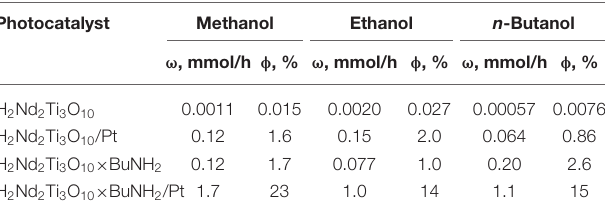
TABLE 1 | Rate of photocatalytic hydrogen evolution ( ω ) and its apparent quantum efficiency at 220–340nm ( φ ) from 1mol.% aqueous methanol, ethanol and n -butanol solutions over H 2 Nd 2 Ti 3 O 10 , H 2 Nd 2 Ti 3 O 10 /Pt,